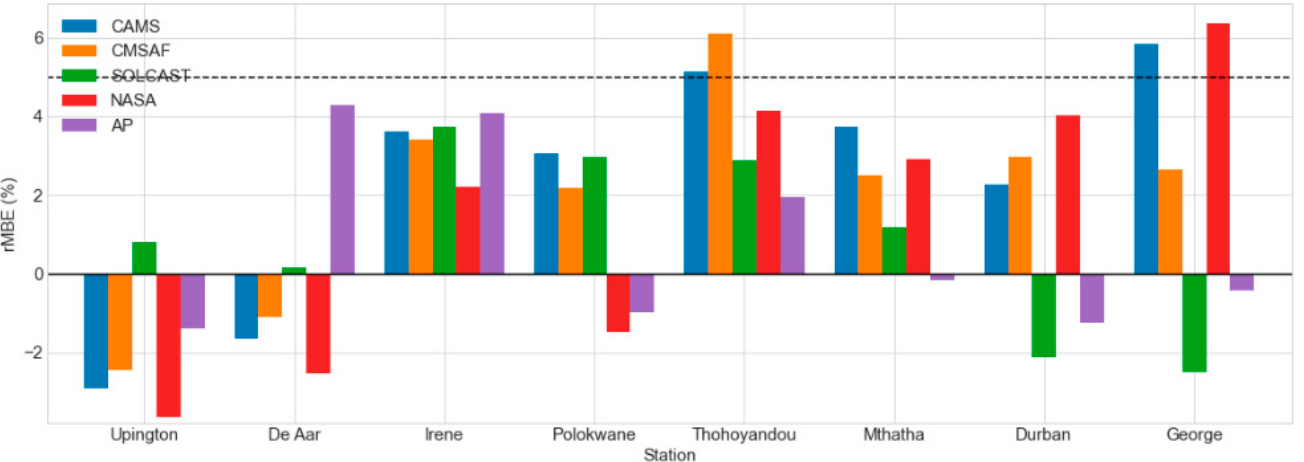
Figure 3. The daily rMBE of estimated GHI datasets in all-sky conditions.